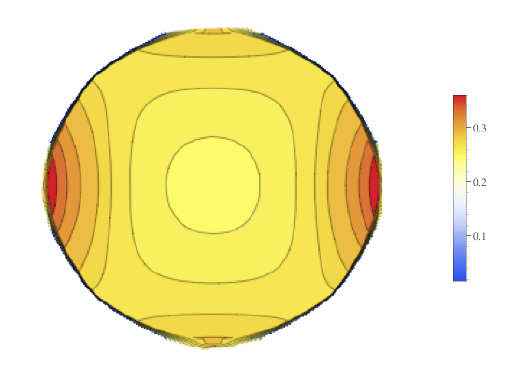
Figure 11. Contour plot of the relative standard deviation for the electrical field experienced by the tumor at 1725 and case